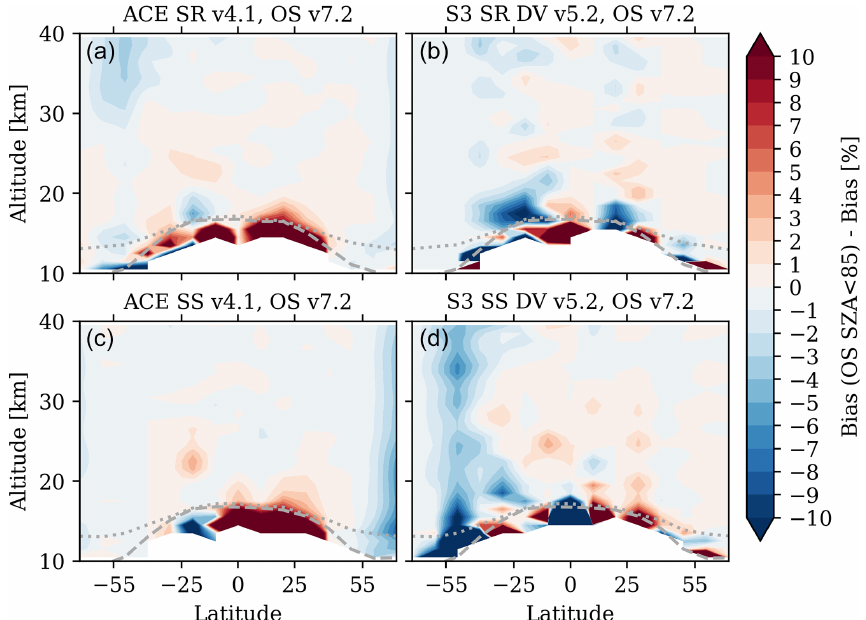
Figure 12. Difference between the bias with and without including OSIRIS scans with SZA < 85 ◦ . (a) ACE-FTS sunrise occultations. (b) SAGE III/ISS sunrise occultations. (c) ACE-FTS sunset occultations. (d) SAGE III/ISS sunset occultations. In all panels the dashed line is the average tropopause altitude, while the dotted line is the average 380K potential temperature